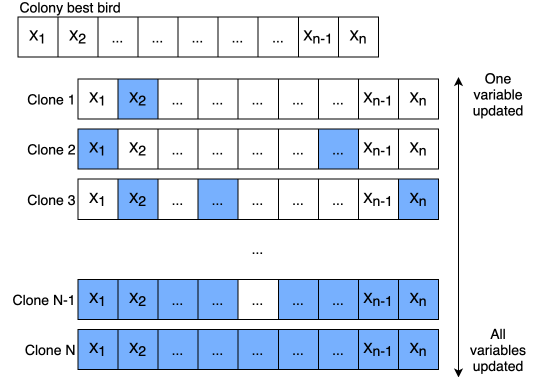
Figure 7. Intensified research step in